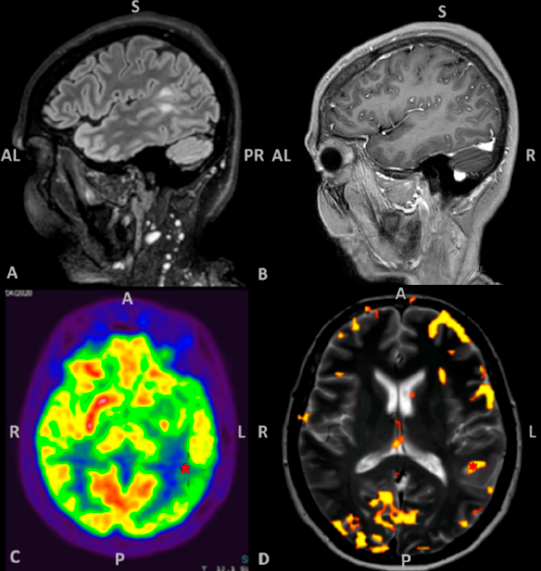
Figure 1. ( A ) 3D FLAIR (fluid attenuated inversion recovery) image discloses a primitive brain tumor located between the posterior part of the superior and middle temporal gyri and the anterior part of the angular gyrus in the left hemisphere; ( B ) the lesion does not enhance after contrast medium administration; ( C ) the 18F-fluorodeoxyglucose PET/MRI reveals the hypometabolism of the tumor (*). ( D ) Axial T2w image fused with the BOLD (blood oxygenation level dependent) signal activation map obtained during word generation task shows a focal cortical activation in the superior–anterior part of the lesion (*).